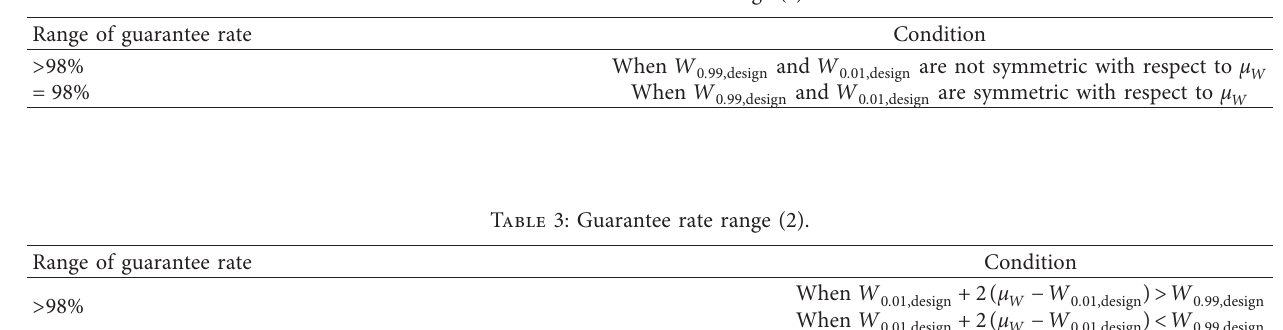
Table 2: Guarantee rate range (1).